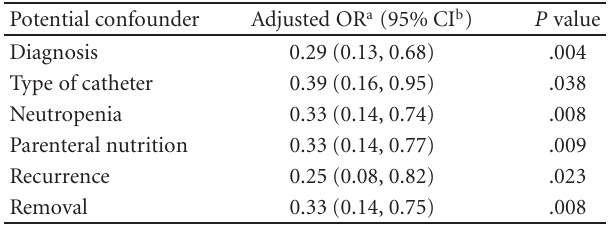
Table 4: Odds ratiosfor the relation between polymicrobial BSI and age of patients adjusted for potential clinical